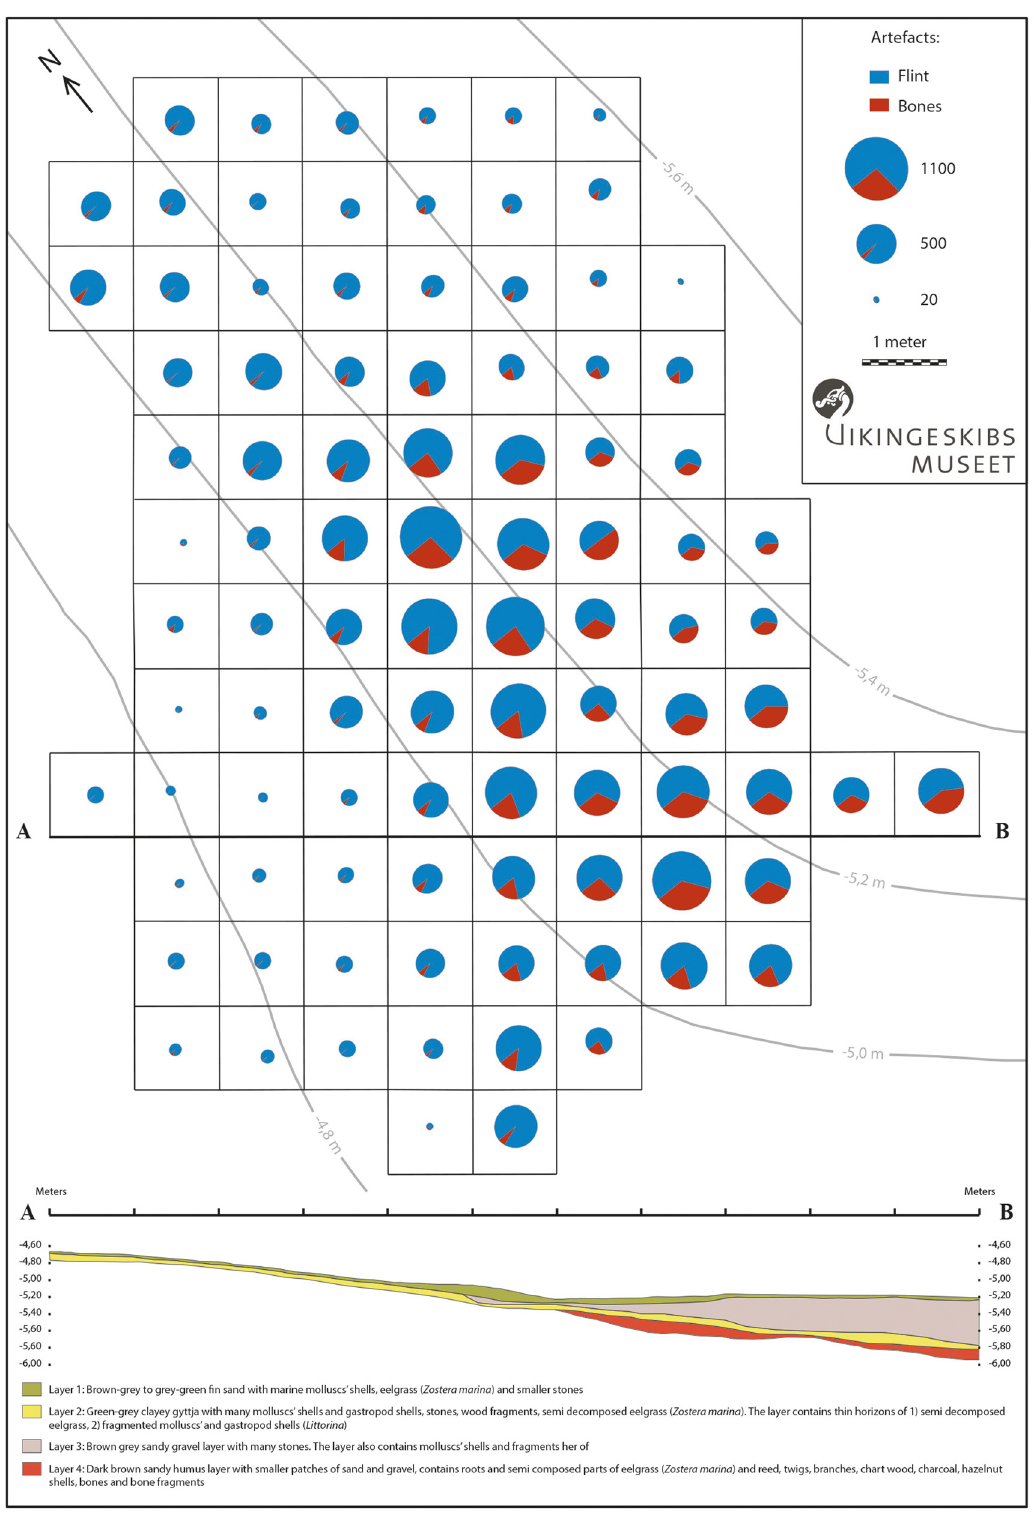
Figure 4: Orehoved Sejlrende , site plan and pro fi le. Contour lines represent the depth of the